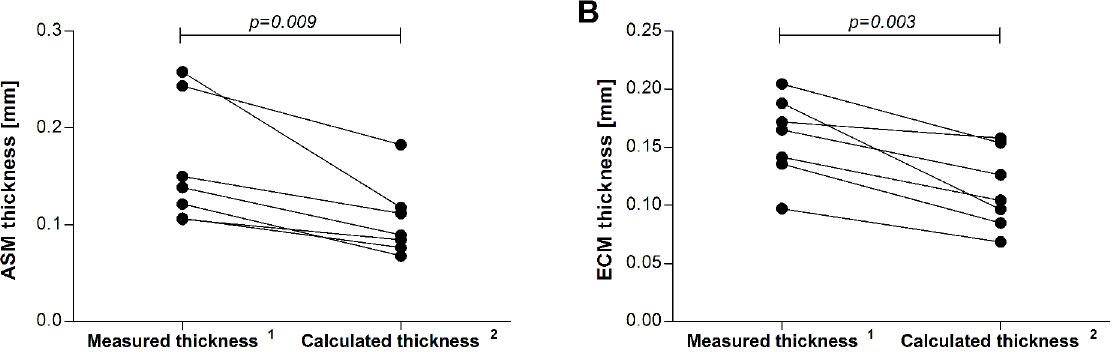
Fig 8. Effect of the method used for measuring ASM (A) and ECM (B) thickness in histologic bronchial samples. Results are shown as mean values per horse. 1 Mean value of 5 measures of ASM or ECM thickness performed manually and randomly around the bronchial circumference (ECM was measured from the basal membrane to the ASM inner border, avoiding regions where obvious collagen fiber shredding occurred). 2 Thickness of the ASM or ECM calculated as function of the ASM or ECM area and airway Pi, as if it was a continuous and homogeneous layer for an airway completely distended (Pi corresponds to the inner circumference of an annulus). Statistical differences were calculated with paired t-tests.